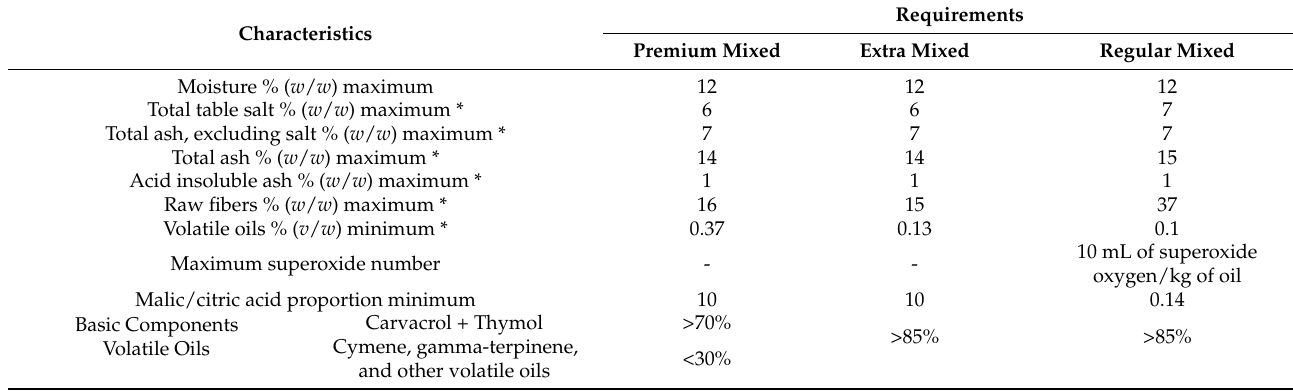
Table 1. Codex Alimentarius chemical requirements for za’atar [10].